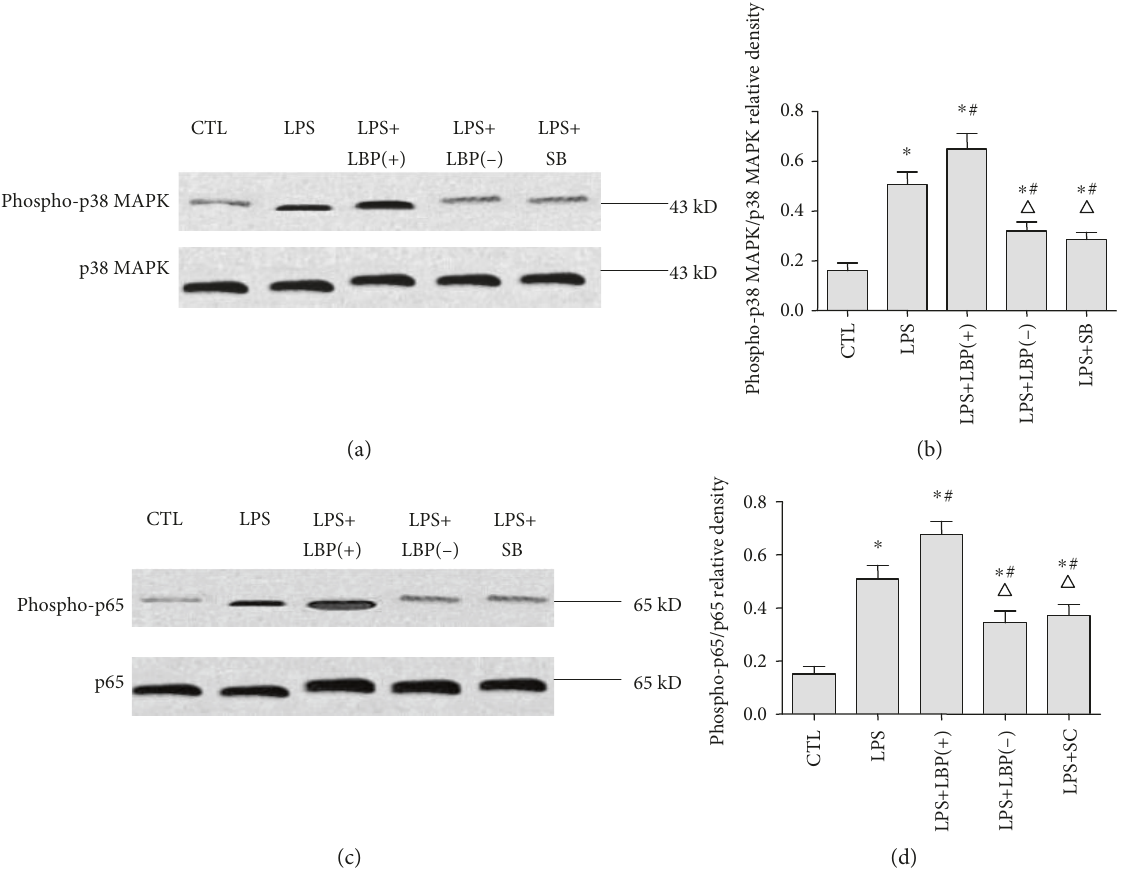
Figure 2: The expressions of phospho-p38 MAPK and phospho-p65 in A549 cells with and without plasmid transfection or inhibitors following LPS treatment. Western blotting was used to image the expression of phospho-p38 MAPK and phospho-p65 in A549 cells with and without plasmid transfection or inhibitors following LPS treatment. A549 cells of the LPS+LBP and LPS+LBP( − ) groups were transfected with LBP plasmid DNA or LBPshRNA-expressing plasmid DNA, respectively, for 48mins following LPS treatment. A549 cells of the LPS+SB and LPS+SC groups were pretreated with SB203580 or SC-514 for 60 mins following LPS treatment. The cells were collected with cell lysis bu ff er 1h after LPS stimulation for western blotting. The fi gure shows that there is increased expression of phospho-p38 MAPK and phospho-p65 in A549 following LPS treatment. Transfection with LBP plasmid DNA increased the expression of phospho-p38 MAPK and phospho-p65. Transfection with LBP shRNA plasmid DNA decreased the expression of phospho-p38 MAPK and phospho-p65. Pretreatment with SB203580 reduced the expression of phospho-p38 MAPK, and pretreatment with SC-514 reduced the expression of phospho-p65 protein. The relative densities of phospho-p38 MAPK/ β -actin (a and c) and phospho-p65/ β -actin (b and d). ∗ represents p < 0 05 when compared with that in the control group; # represents p < 0 05 when compared with that in the LPS group; △ represents p < 0 05 when compared with that in the LPS+LBP(+). Data are presented as means ± SD of six independent experiments ( n = 6